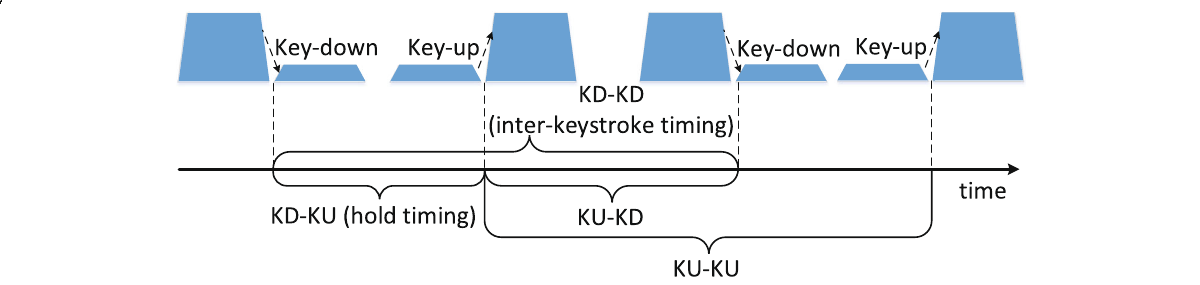
Fig. 3 Keystroke timings used in keystroke dynamics